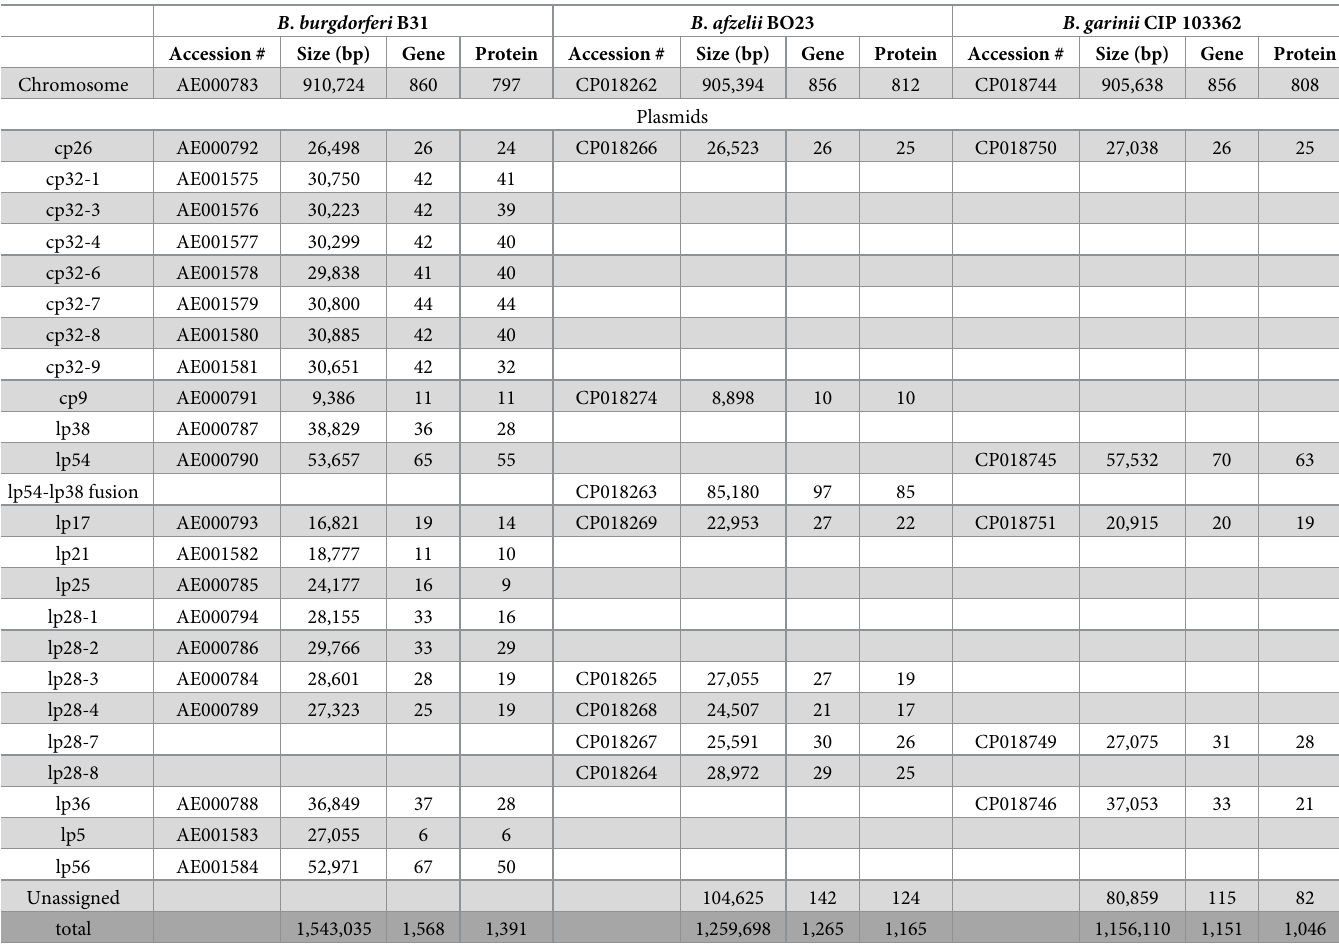
Table 1. Comparison of the genome of the three Borrelia